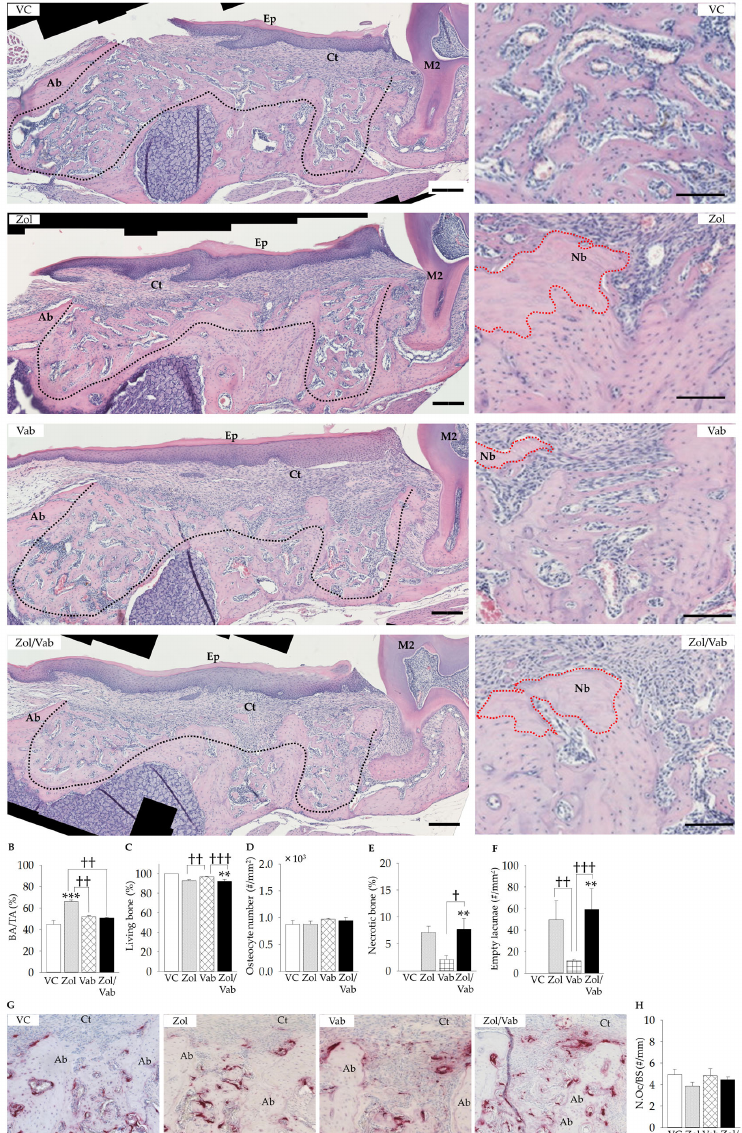
Figure 4. Effects of administered drugs on osseous wound healing of tooth extraction sockets. ( A ) Representative hematoxylin and eosin-stained sagittal images of tooth extraction sockets [small (left) and higher (right) magnification, black and red dotted line: tooth extraction sockets and necrotic bone, respectively, bar: 200 µ m]. ( B ) Bone area per tissue area (BA/TA) in the tooth extraction sockets is significantly increased in Zol vs. other comparison groups. ( C ) Living bone area (living bone) is significantly decreased in Zol/Vab vs. VC and Vab. ( D ) The distribution of osteocytes in the bone tissue (osteocyte number) is almost the same among the groups. ( E ) Necrotic bone area (necrotic bone) is significantly increased in Zol/Vab vs. VC and Vab, whereas it is increased in Zol vs. VC, but not significantly. ( F ) The distribution of empty lacunae (empty lacunae) in bone tissue is significantly increased in Zol/Vab vs. VC and Vab, and in Zol vs. Vab, whereas it is increased in Zol vs. VC, but not significantly. ( G ) Representative TRAP-stained images of tooth extraction sockets (Ab: alveolar bone, CT: connective tissue, bar: 100 µ m). ( H ) The number of osteoclasts on the bone surface in the tooth extraction sockets is similar among the groups. Graphs show means ± SEM. ** p < 0.01, *** p < 0.001, † p < 0.05, †† p < 0.01, ††† p < 0.001; n = 5